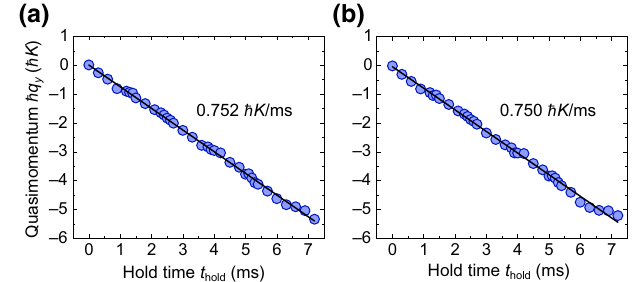
FIG. 7. Calibration of quasimomentum versus t hold . Panels (a) and (b), corresponding to the spin components | 1 (cid:2) and | 4 (cid:2) , respectively, are obtained from the band-1 transport experiment in Fig. 2. Dots are experimental data and lines are linear fits.